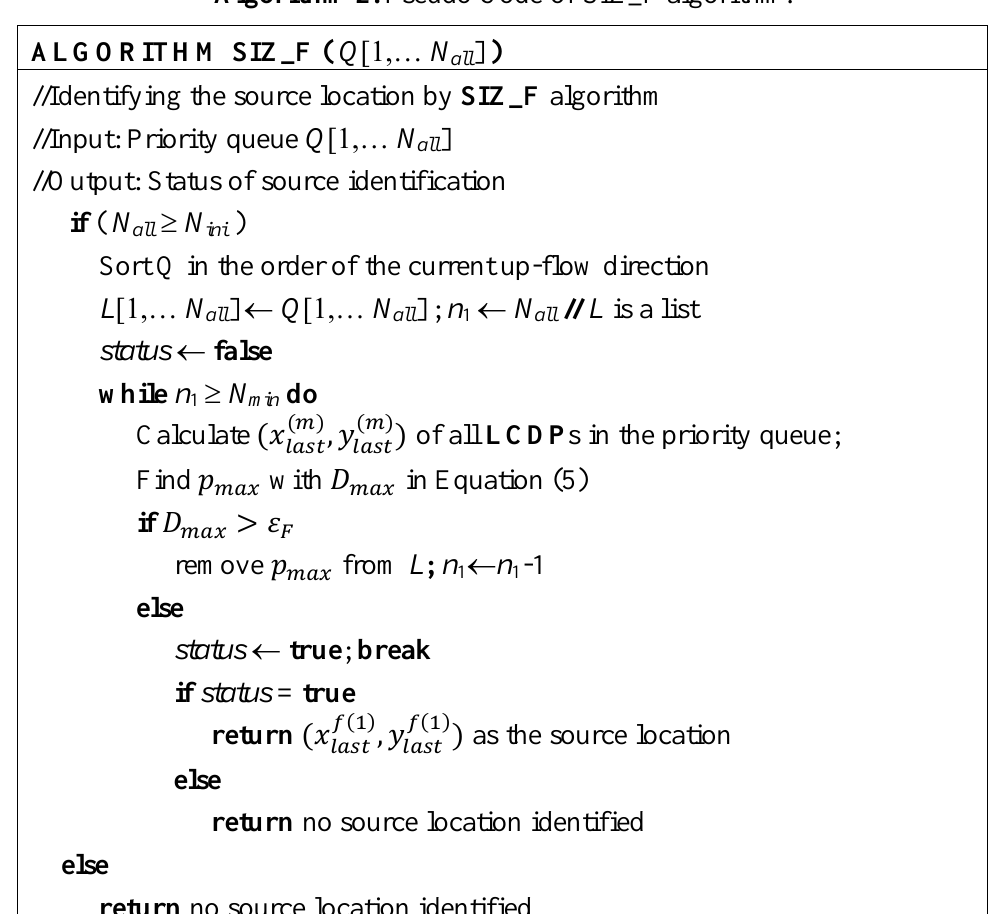
Algorithm 2. Pseudo Code of SIZ_F